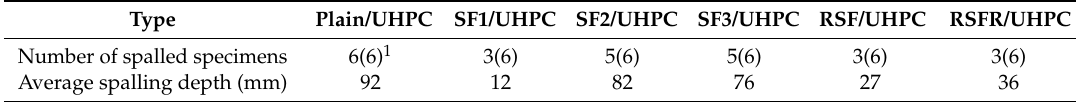
Table 4. Occurrence of explosive spalling of all UHSC types exposed to high temperature.